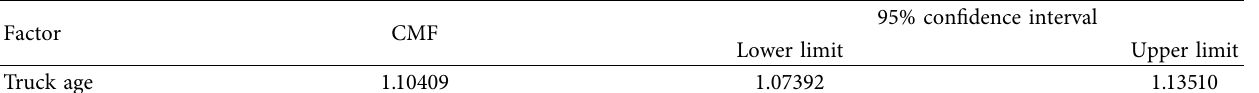
Table 7: Crash modification function of truck age for truck crashes occurring due to mechanical failure.